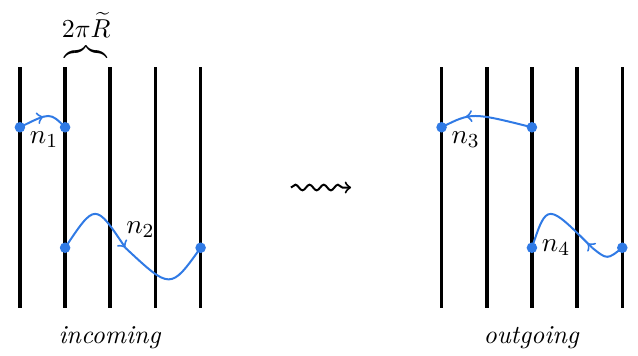
Figure 2 . A four-point open string amplitude with n 1 = 1 , n 2 = 3 , n 3 = − 2 , and n 4 = − 2 . The vertical lines represent an array of equidistantly separated D-branes localized along the compact circle of radius R . The seemingly noncompact direction along which the D-branes are localized is understood to have an x ∼ x + 2 πR identification. The distance between consecutive D-branes in the array is 2 π e R , where e R = α 0 /R is the radius of the T-dual circle. The blue wavy lines represent fundamental strings with their ends residing on different D-branes. During the scattering process, the two incoming strings join into one at the second D-brane from the left; then, the single intermediate string splits at the third D-brane into two outgoing strings. The open strings may also wind around the full compact circle for multiple times. There are n + + 1 = 5 D-branes for this choice of closed string quantum